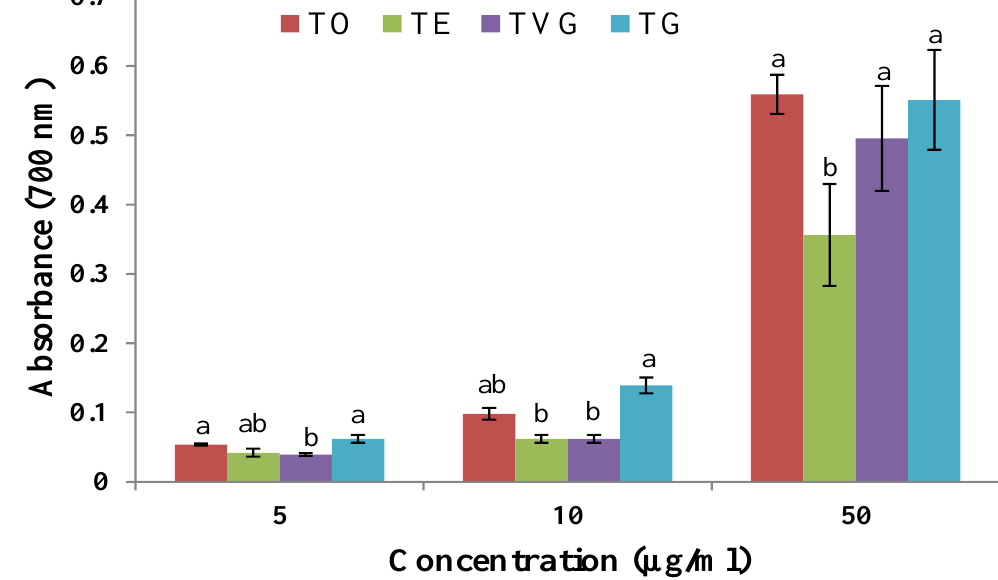
Figure 1. Ferric-reducing power of four different tannin isolates. TO: tannin oenologique; TVG: tannin VR grape; TG: tannin galalcool; TE: tannin VR supra elegance. Mean ± SD (N = 3). Means with different letters are significantly different ( p < 0.05).